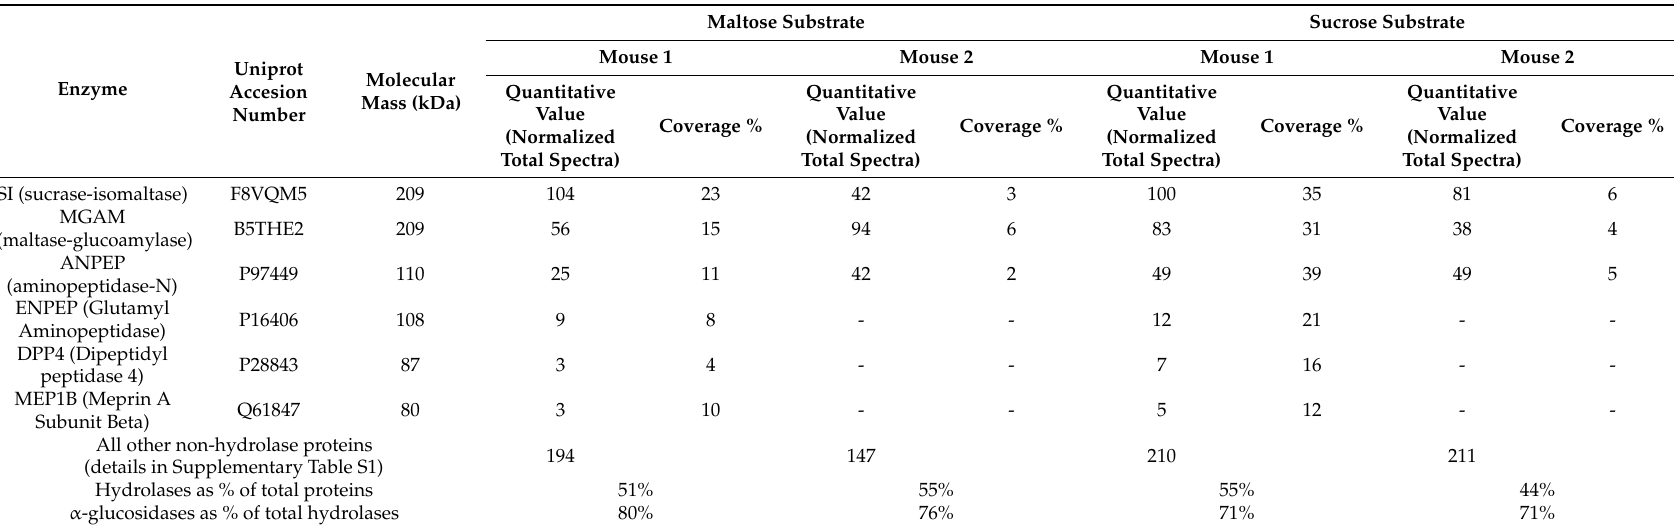
Table 2. Hydrolases identified by nano-liquid chromatography coupled to mass spectrometry in the slices cut from gels incubated with maltose and sucrose. Quantitative value and coverage of enzymes in the analyzed sample was determined using Sca ff old software package (version 4.3.2, Proteome Software Inc., Portland, OR, USA). The % coverage refers to the percentage of the protein sequence covered by identified peptides. Protein identifications were accepted if they could be established at greater than 99.0% probability with a 1% false discovery rate and containing at least 5 identified